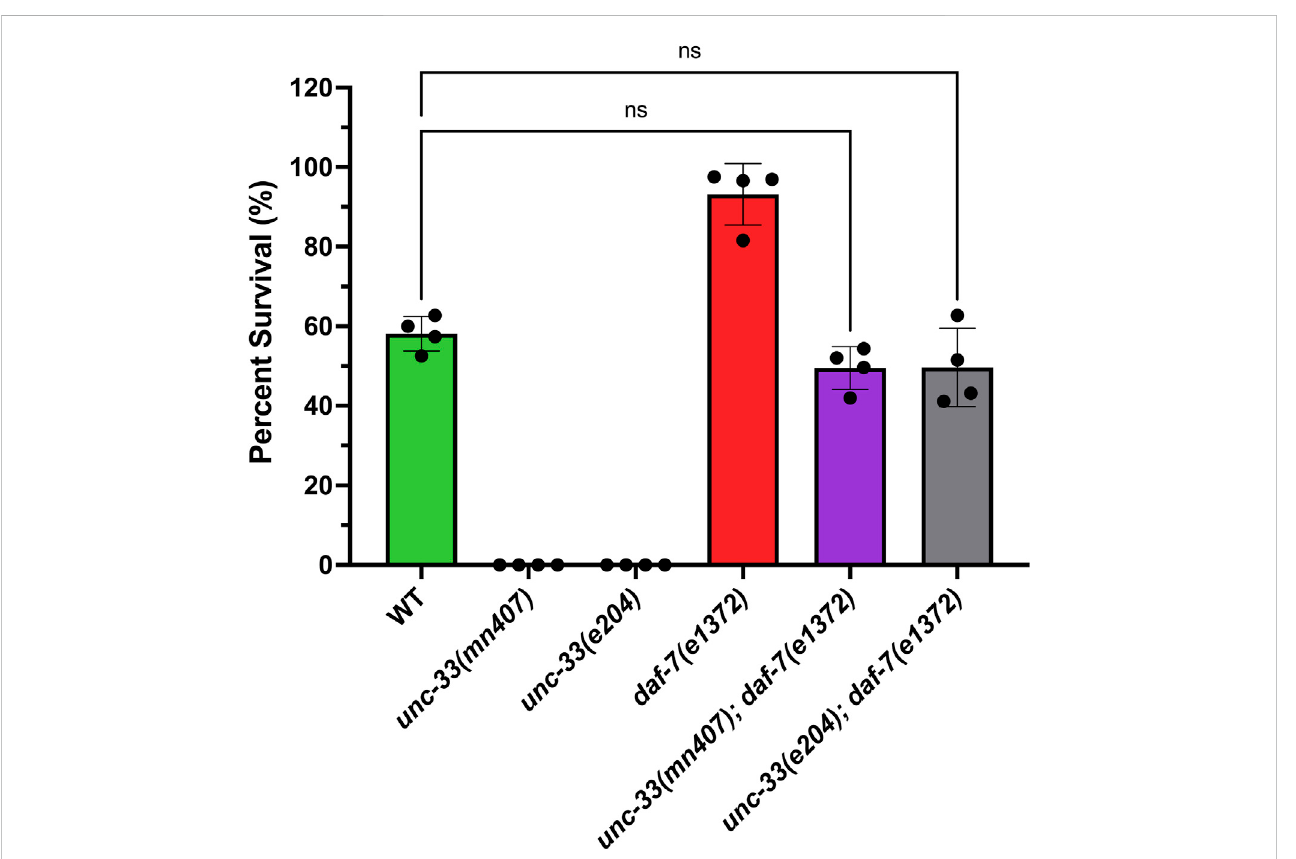
FIGURE 1 Addition ofthe daf-7 mutationinto unc-33 mutants restoresdauerformation. Percentsurvivalofall strainsafterstimulationofdauerformation followed by1%SDStreatmentwasquanti fi ed. unc-33(mn407) and unc-33(e204) hadnodetectablesurvivalto1%SDScon fi rmingthat unc-33 mutantsareincapableof formingdauers.Analysisofone-wayANOVAwithTukey ’ smultiplecomparisonstestshowsthatthepercentsurvivalofdoublemutants unc-33;daf-7 wasnot statistically different from wildtype. However, unc-33(mn407) and unc-33(e204) were statistically different from wildtype ( p < 0.0001). Plotted is the mean percent survival +/- standard deviation of 4 independent replicas per strain. ns = not signi fi